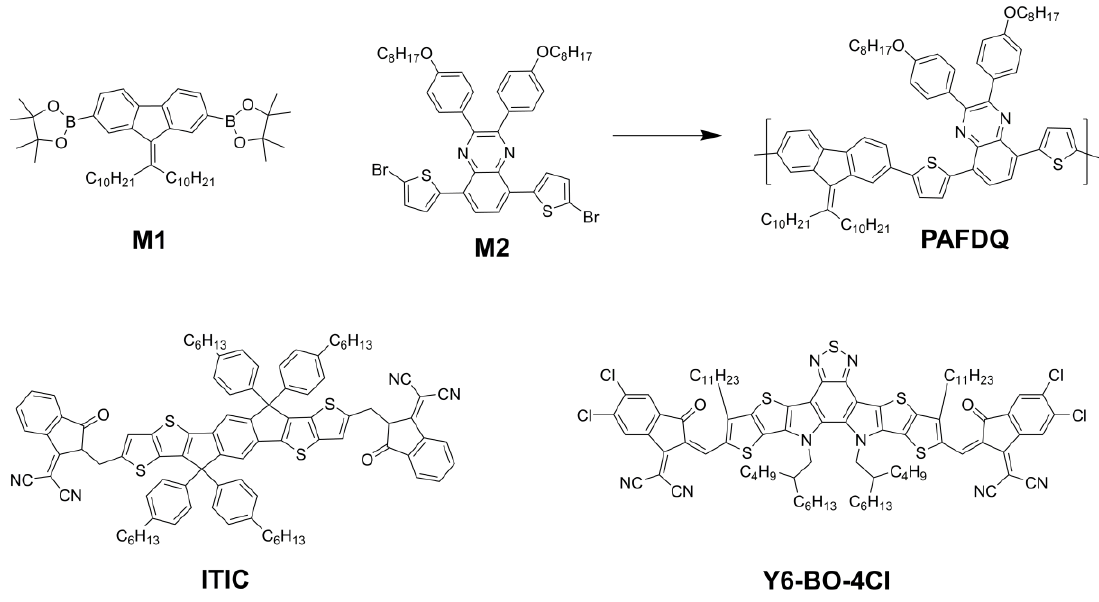
Scheme 1. Monomer synthesis and